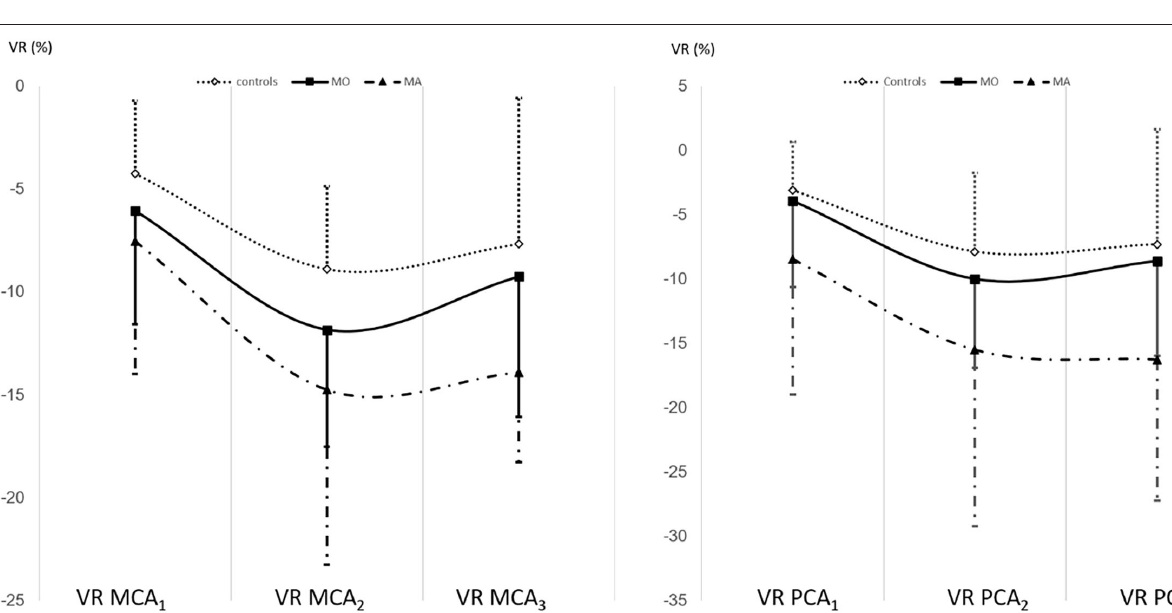
while the distal segment is contristed due to action of pCO2 to maintain constant cerebral blood